Question: Write a single sentence explaining what this figure depicts.
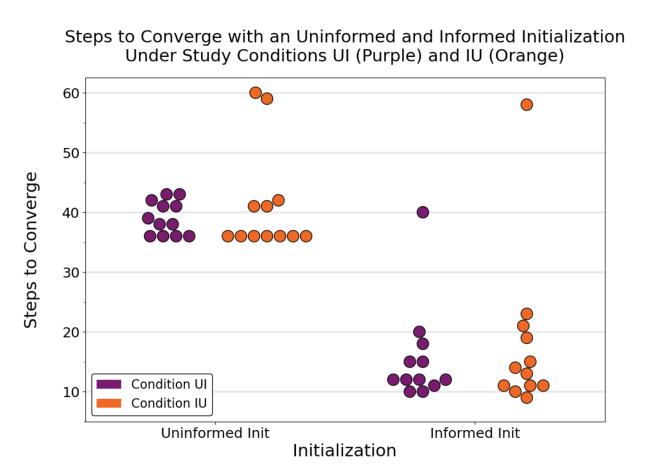
Answer: Dot plot depicting the number of steps the learning algorithm took to converge for each user from Subtask U (Uninformed Init) and Subtask I (Informed Init) under study conditions UI (Purple) and IU (Orange).